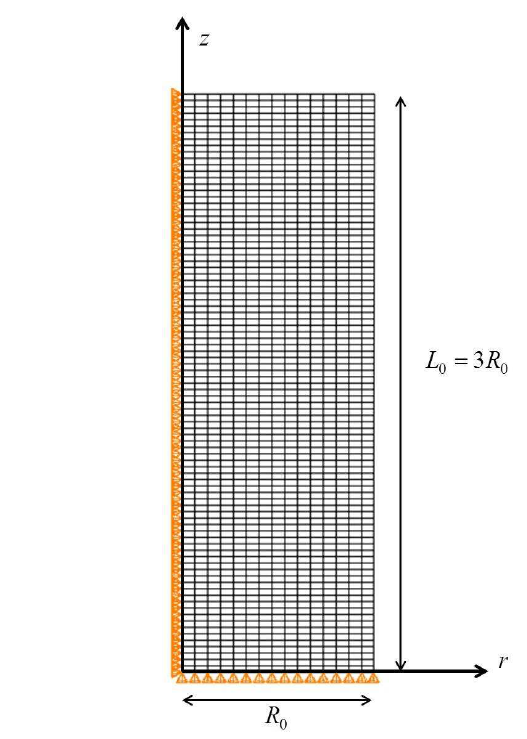
Figure 14. The finite element model employed for the analysis and a schematic representation of the boundary conditions imposed.